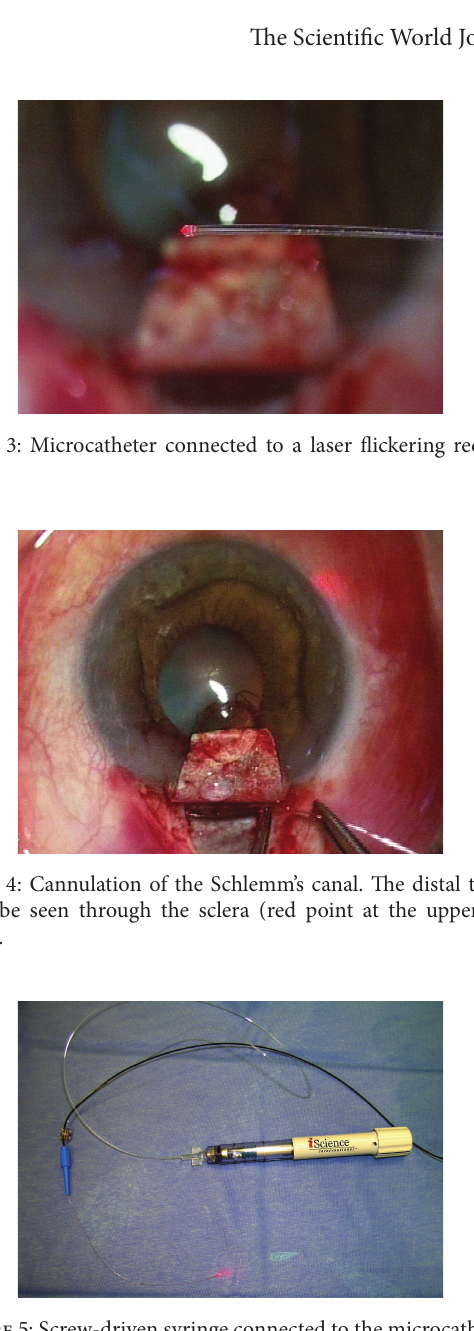
Figure 5: Screw-driven syringe connected to the microcatheter.